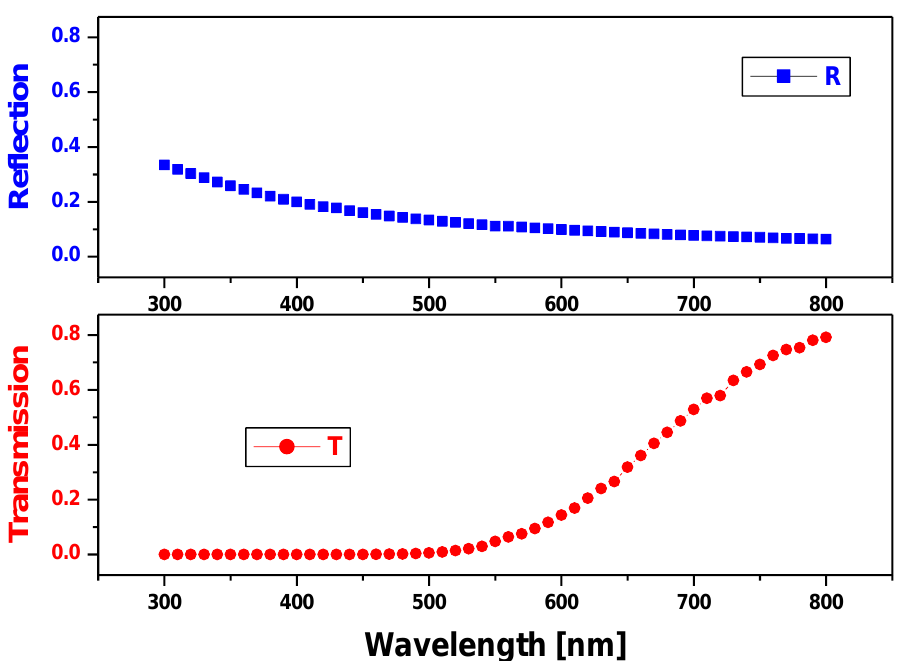
Figure 5. Spectrum of transmission and reflection for ternary anti-reflecting solar cells made on hydrogenated amorphous silicon (a-Si: H) with texturing on the top surface with heights equal to 50 nm. The ternary ARC is composed of silicon nitride with a thickness of 33 nm immersed between silicon dioxide and titanium dioxide with a thickness of 54 nm and 82 nm, respectively.